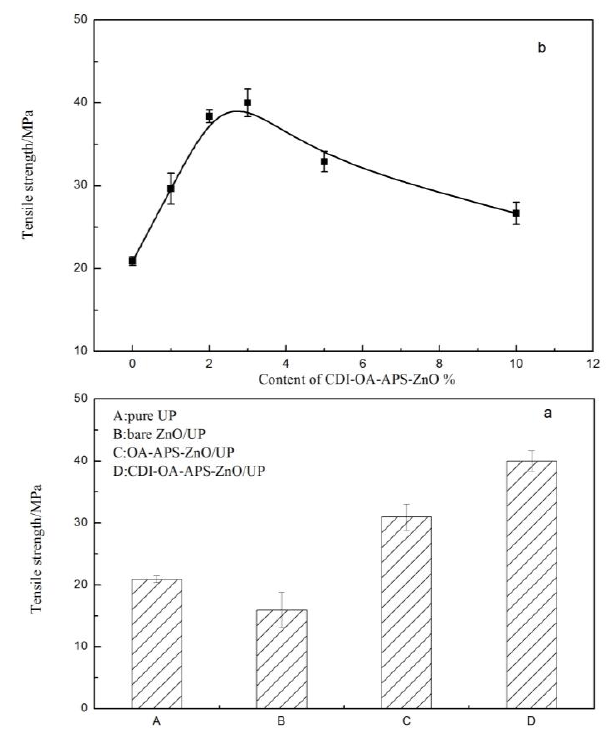
Figure 9. Tensile strength profiles of UP composite films with ( a ) different kinds of ZnO nanoparticles and ( b ) different content.